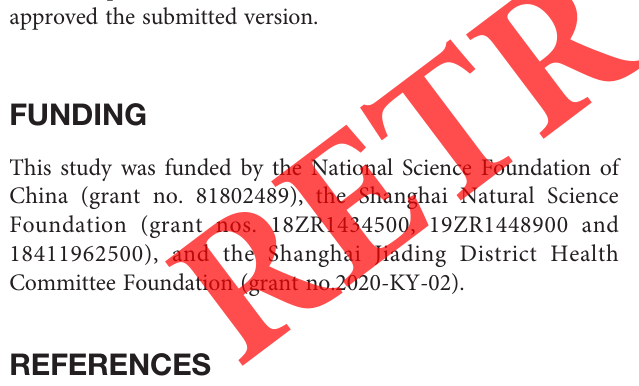
Supplementary Figure 1 | (A) miR-193b-3p expression was measured by qRT- PCR in U87 and U251 cells after miR-193a-3p mimics transfection. All expression was normalized to the level of U6 small nuclear RNA expression. Ns, no signi fi cant. (B) Authentication of biological targets of miR-193a-3p in the three databases (TargetScan, RNA22 and miRmap) through Venn diagrams software (available online: http://bioinformatics.psb.ugent.be/webtools/Venn/). Different color meant different databases. Supplementary Figure 2 | AKT1, AKT3, Bad and Bax protein expression measured by Western-blot analysis. No signi fi cant difference was found between miR-NC group and miR-193a-3p mimics group in U87 glioma xenograft model. Supplementary Figure 3 | Cell growth was determined in A172 cells transfected with miR-193a-3p mimics by MTT assay at 24, 48, 72, 96, 120h. Supplementary Figure 4 | The original Western blots of total AKT1, total AKT2, total AKT3, p-AKT1, p-AKT2, p-AKT3, Bcl-2, Bad, Bax, and Survivin in U87 and U251 cells transfected with miR-193a-3p mimics or miR-NC. Supplementary Figure 5 | TheoriginalWesternblots ofALKBH5proteinlevelsin U87cellstransfectedwithmiR-NC,miR-193a-3pmimics,anti-NCandanti-miR-193a-3p. Supplementary Figure 6 | The original Western blots of ALKBH5 expression in glioma cell lines (A172, SGH44, LN229, U251, and U87) and in U251 and U87 cells transfected with ALKBH5-targeted siRNA. Supplementary Figure 7 | The original Western blots of ALKBH5, total AKT1, total AKT2, total AKT3, p-AKT1 p-AKT2, p-AKT3, Bcl-2 and Survivin in U87 and U251 glioma cells co-transfected with miR-193a-3p mimics and Lenti-ALKBH5. Supplementary Figure 8 | The original images for blots of Figures 6A – F . Supplementary Figure 9 | The original Western blots of AKT2-protein stability after ALKBH5 treatment. Supplementary Figure 10 | The original Western blots of ALKBH5, total AKT2, p-AKT2, Bcl-2, and Survivin protein expression in puri fi ed tumors. Supplementary Table 1 | Thedetailedclinicopathologiccharacteristicsof28patients withdiffuse astrocytoma, 63 patientswith glioblastomasand32normalbrain tissues. Supplementary Table 2 | The candidate potential target genes of miR-193a-3p in the three databases (miRmap, TargetScan and